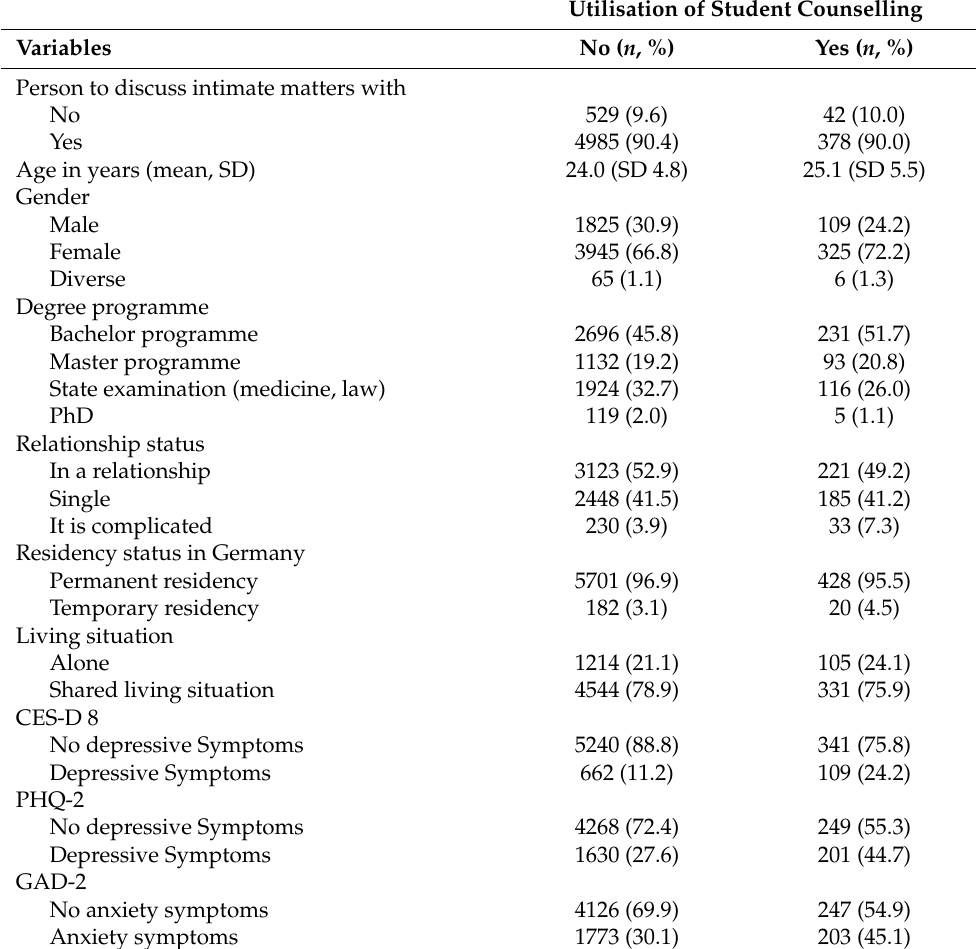
Table 6. Utilisation of student counselling by student